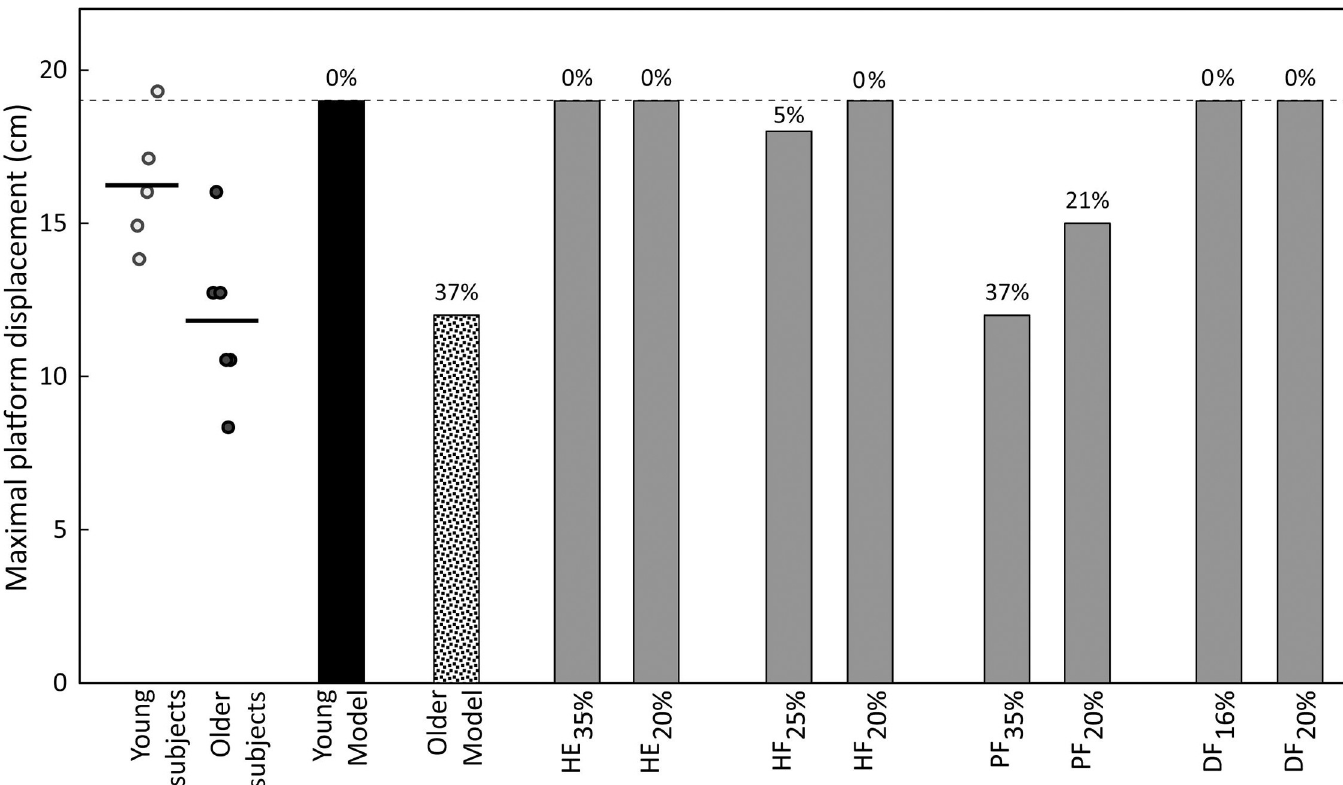
Fig 3. Maximal platform displacement for young and older human subjects (horizontal line indicates mean for each group), and for simulations of different cases of strength loss. Data labels represent the percent reduction in maximal platform displacement compared to the young model (19 cm).